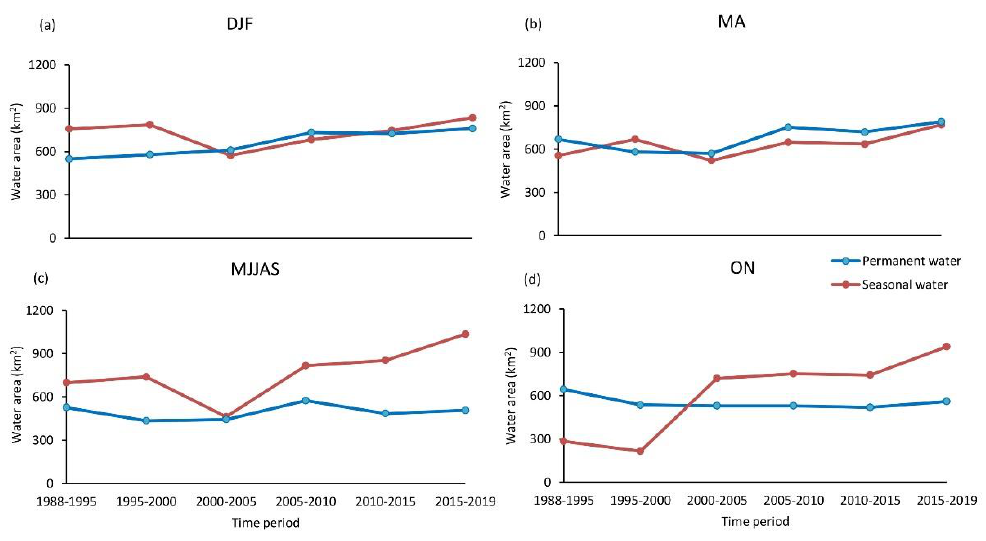
Figure 8. The variations of water area during different seasons in Sri Lanka. During ( a ) DJF, ( b ) MA, ( c ) MJJAS, and ( d ) ON.